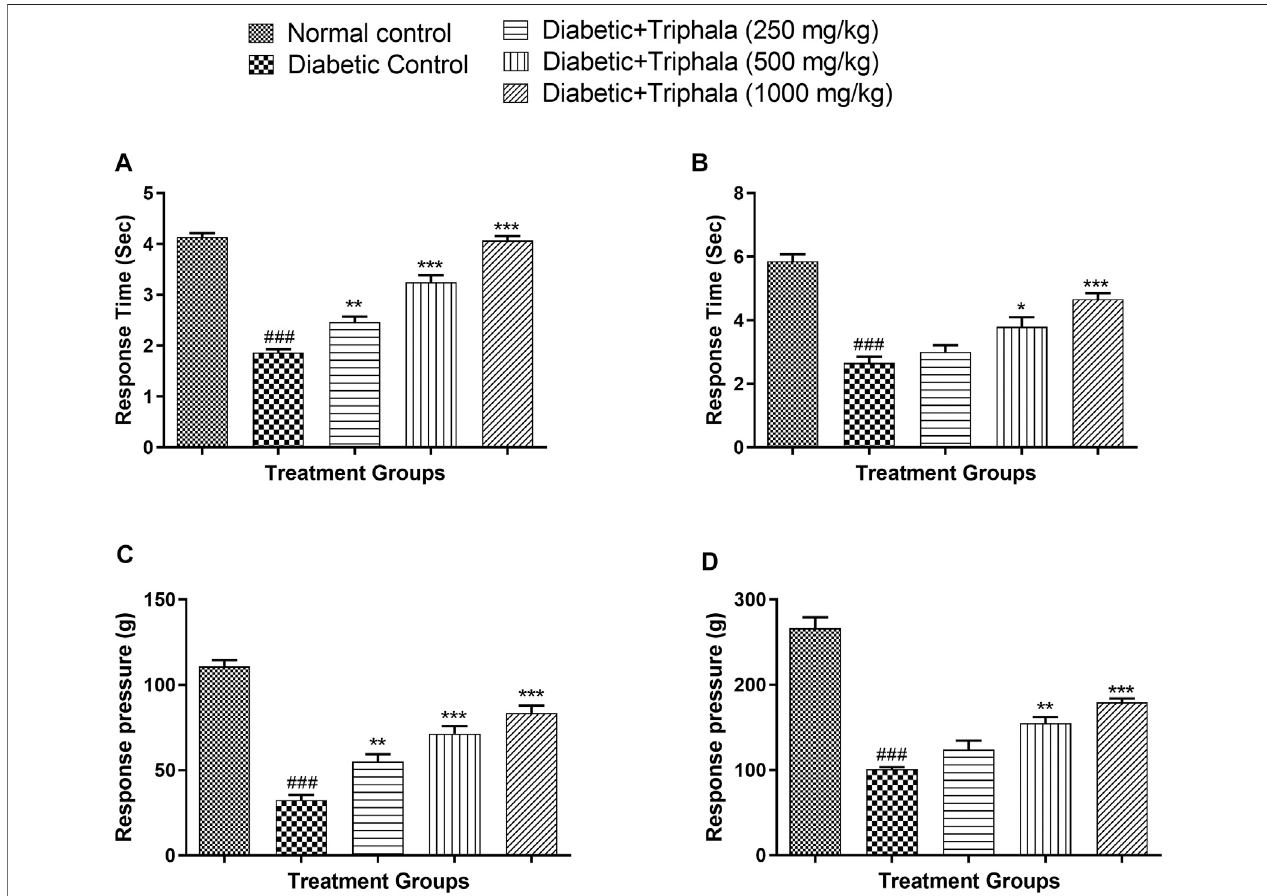
FIGURE 2 | Effect of Triphala churna in (A) Hot plate test; (B) Tail immersion test; (C) Von Frey test; (D) Randall Selitto test. Data are expressed as mean ± S.E.M. ( n (cid:2) 6), ### p < 0.001 when compared to normal control, * p < 0.05, ** p < 0.001, *** p < 0.001 when compared to diabetic control.